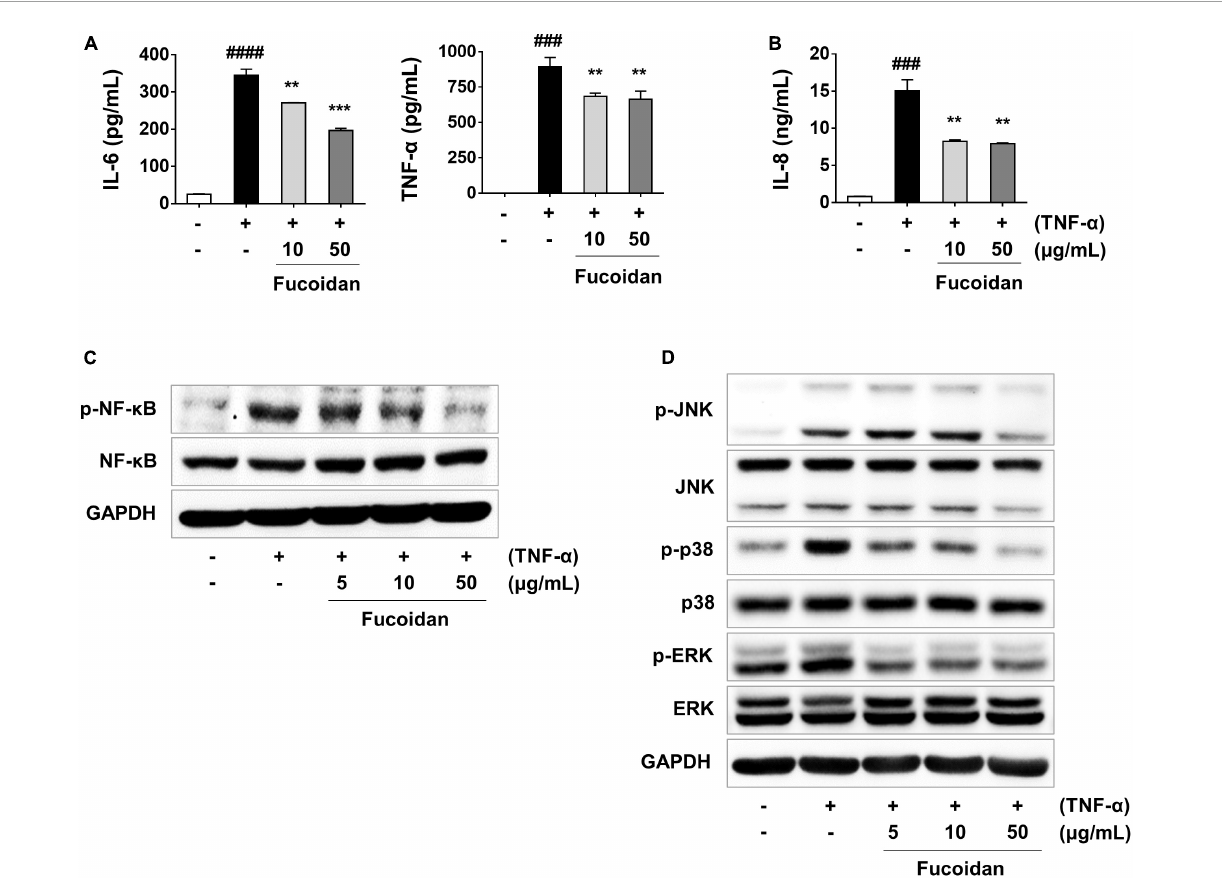
FIGURE7 Anti-inflammatory effect of fucoidan on cytokine production and NF- κ B/MAPK signaling in TNF- α -stimulated ARPE-19 cells. ARPE-19 cells were pre-treated with fucoidan for 1 h and then stimulated with 50 ng/mL of TNF- α for 24 h. (A) Levels of the cytokines IL-6 and TNF- α , and (B) level of the chemokine IL-8. The production of cytokines and chemokines was measured by ELISA. Effect of fucoidan on NF- κ B and MAPK signaling pathways. (C) Western blotting for NF- κ B in cells pre-treated with fucoidan for 3 h and then stimulated with 50 ng/mL of TNF- α for an additional 30 min. (D) Western blotting for MAPKs in cells pre-treated with fucoidan for 30 min and then stimulated with 50 ng/mL of TNF- α for 30 min. GAPDH was used as a loading control. The values represent the mean ± SD of three independent experiments. ### p < 0.001, #### p < 0.0001 compared with the control. ** p < 0.01 and *** p < 0.001 compared with the TNF- α -treated control,